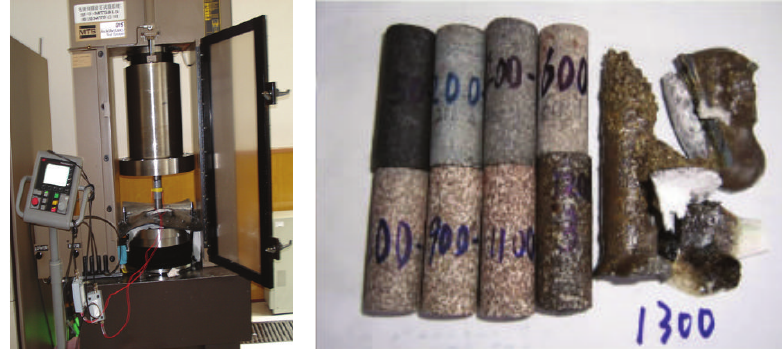
Figure 1: Appearance of MTS815.02 system and heated rock samples.